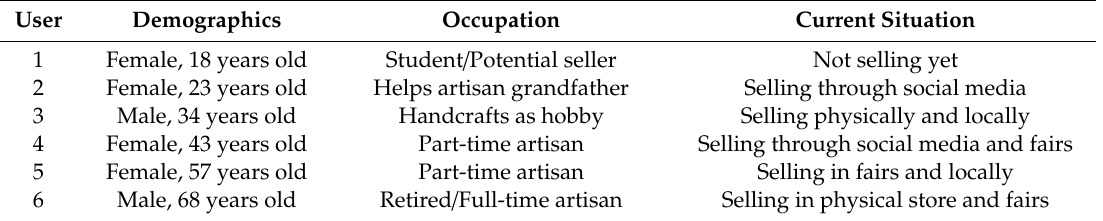
Table 3. Seller sample. Self-source, 2020.